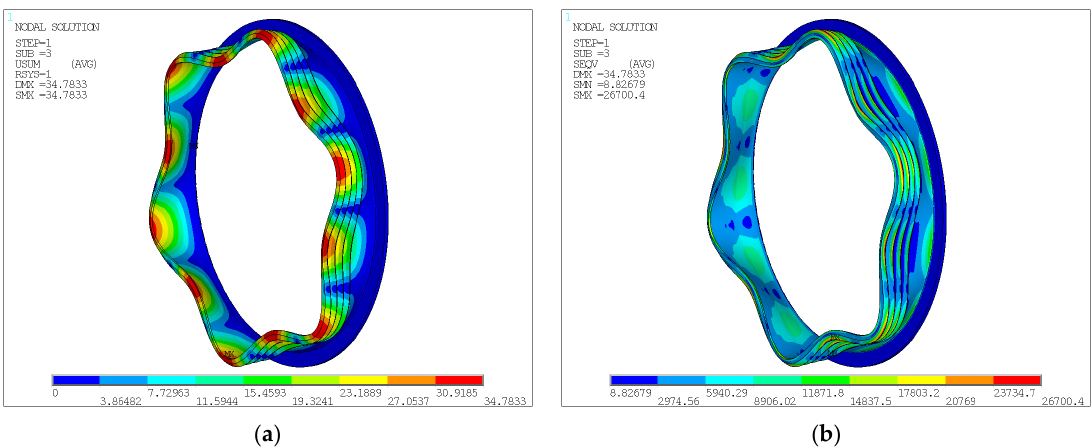
Figure 19. 6 ND first mode for the labyrinth seal: ( a ) Displacement vector sum; ( b ) Von Mises stress. Table 3. Modal parameters for the labyrinth seal.